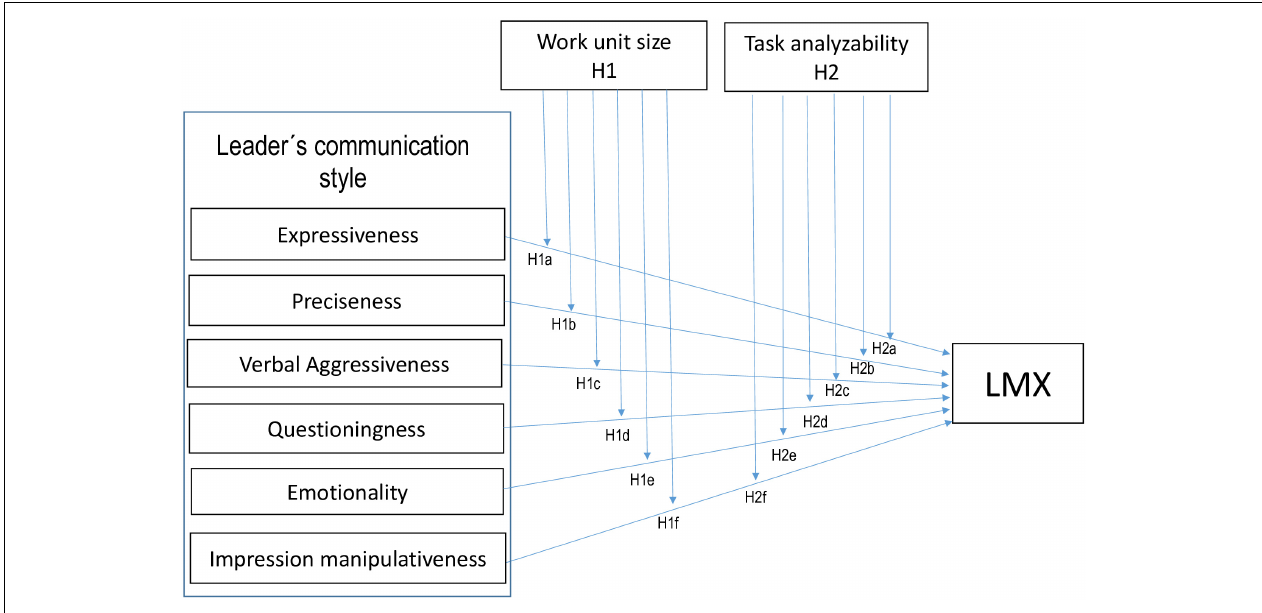
FIGURE 1 | The research